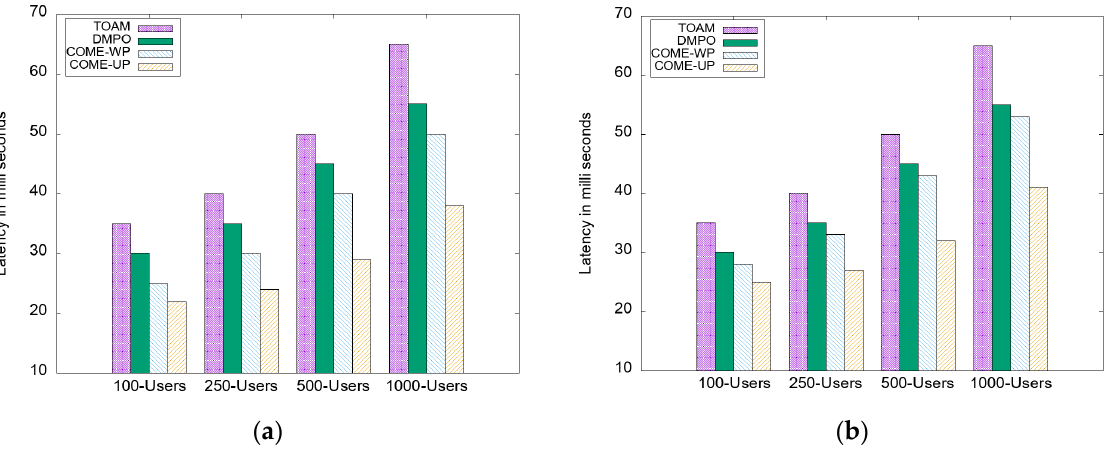
Figure 5. Latency; (𝐚) 𝛂 = 0.5 , β = 0.25, ϒ =0.25; (𝐛) α = 0.3, β = 0.3, ϒ = 0.3 .